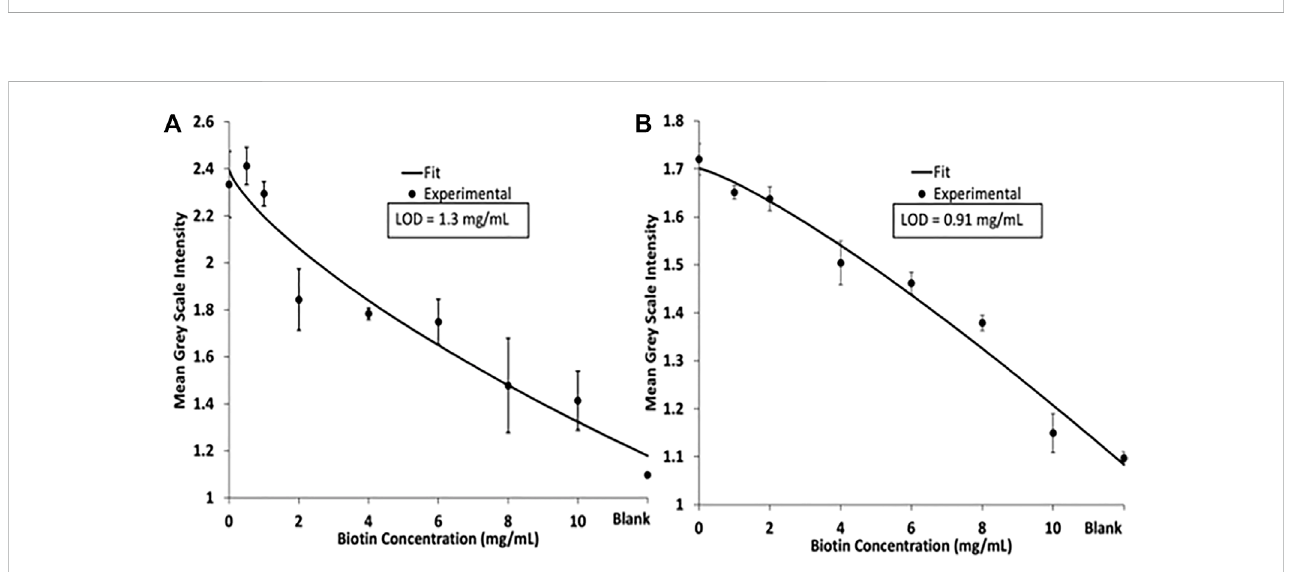
FIGURE 5 (A) 4 PL logistic curve of a biotin competitive assay performed in PBS. (B) 4 PL logistic curve of biotin competitive assay in human pooled